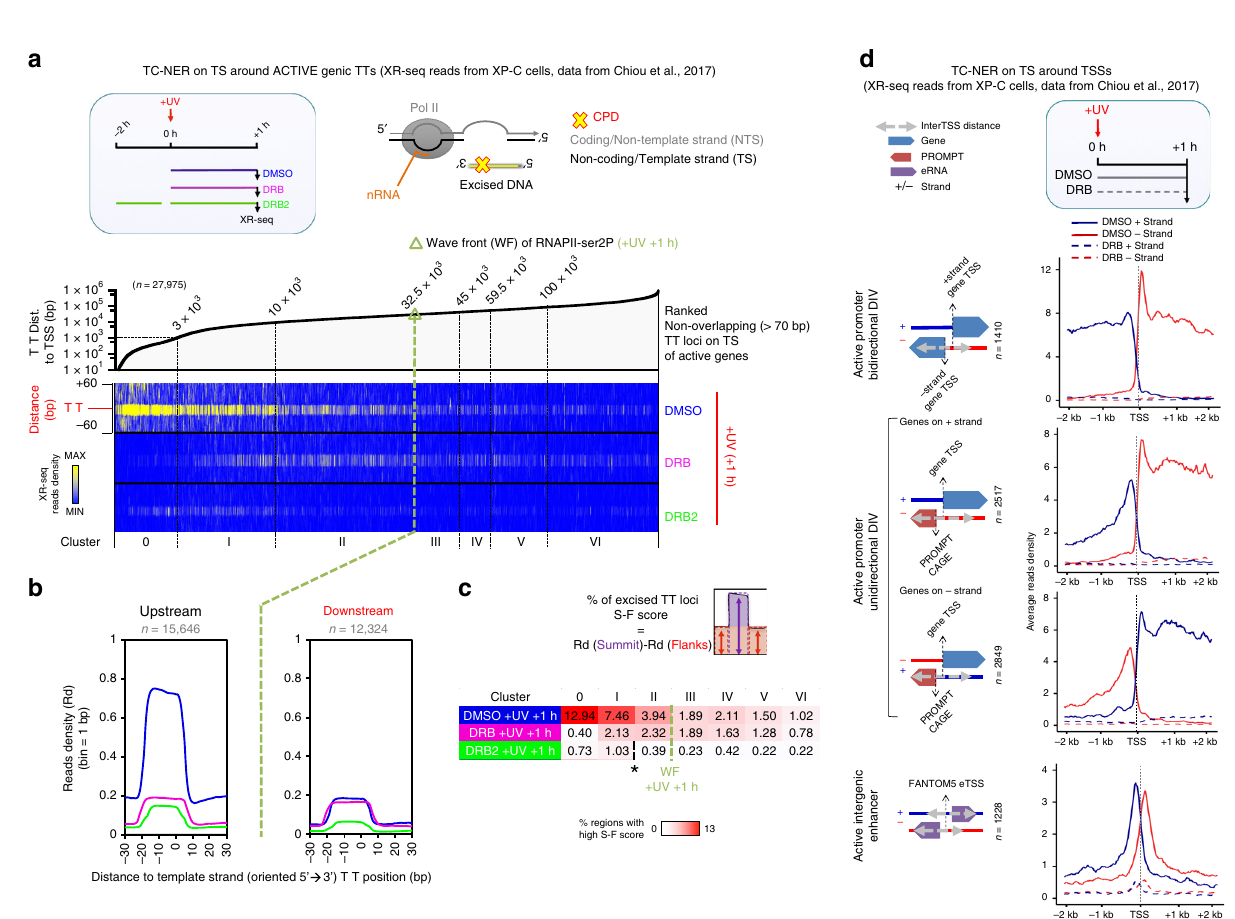
Fig. 7 TC-NER activity monitored with various regimes of DRB reveals the need for continuous transcription initiation. a Heatmap depicting the distribution of excised DNA fragments (XR-seq) derived from TC-NER activity (XP-C cells). Reads were aligned around TT loci of the transcribed strand, localized on active genes. Data were obtained from ref. 38 . The box in blue border (left) illustrates the experimental timeline followed and the respective drug treatments. b Average plots of read densities (Rd) showed in a but for clusters upstream (0, I, and II) and downstream (III, IV, V, and VI) of Pol II- ser2P wave front (WF) as de fi ned in ref. 25 for + UV ( + 1 h) condition. c Plot showing the percentage (%) of excised TT loci, as calculated by the difference between Rd at summit (S) and Rd at fl anks (F) (S – F score) from all clusters presented and analyzed in a and b . WF is indicated, and asterisk indicates where drastic decreases in the XR-seq signal occur in DRB2 experiments. d Average pro fi le of read densities of XR-seq signal derived from XP-C cells. Dashed lines illustrate the XR-seq signal in + (blue) or − (red) strand, in the presence of DRB (see “ Methods ” for We reasoned that the high extent of ongoing repair activity Accordingly, allowing only a limited number of pri-elongating detected without DRB (UV + DMSO) is the result of the molecules to be launched just before the irradiation, while continuity in Pol II initiation. To con fi rm this directly, we preventing de novo Pol II release after stress (Fig. 7a – c, DRB2 + mapped XR-seq reads around TTs located on TS 1, 4, and 8 h UV + 1 h) highlights how an insuf fi cient feed in Pol II impairs after UV in WT cells (data obtained from ref. 46 , see “ Methods ” ). TC-NER activity at both distal and proximal transcribed regions (compare signal before and after asterisk positions in Fig. 7 a, c). We found that signi fi cant levels of transcription-dependent